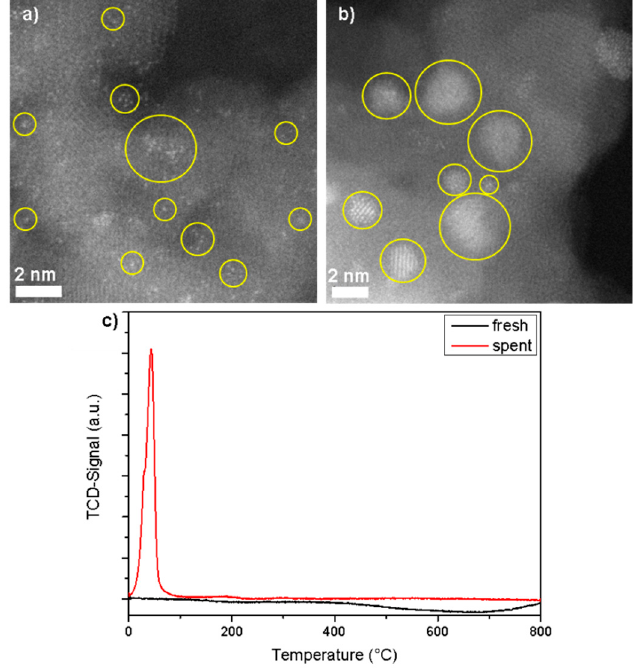
Figure 1. Catalyst characterization. High-angle annular dark-field—scanning electron microscopy (HAADF-STEM) images: ( a ) fresh Rh1/Al 2 O 3 , ( b ) spent Rh1/Al 2 O 3 , and ( c ) H 2 -TPR (temperature programmed reduction with H 2 ) profiles of fresh and spent Rh1/Al 2 O 3 . Spent catalysts were isolated